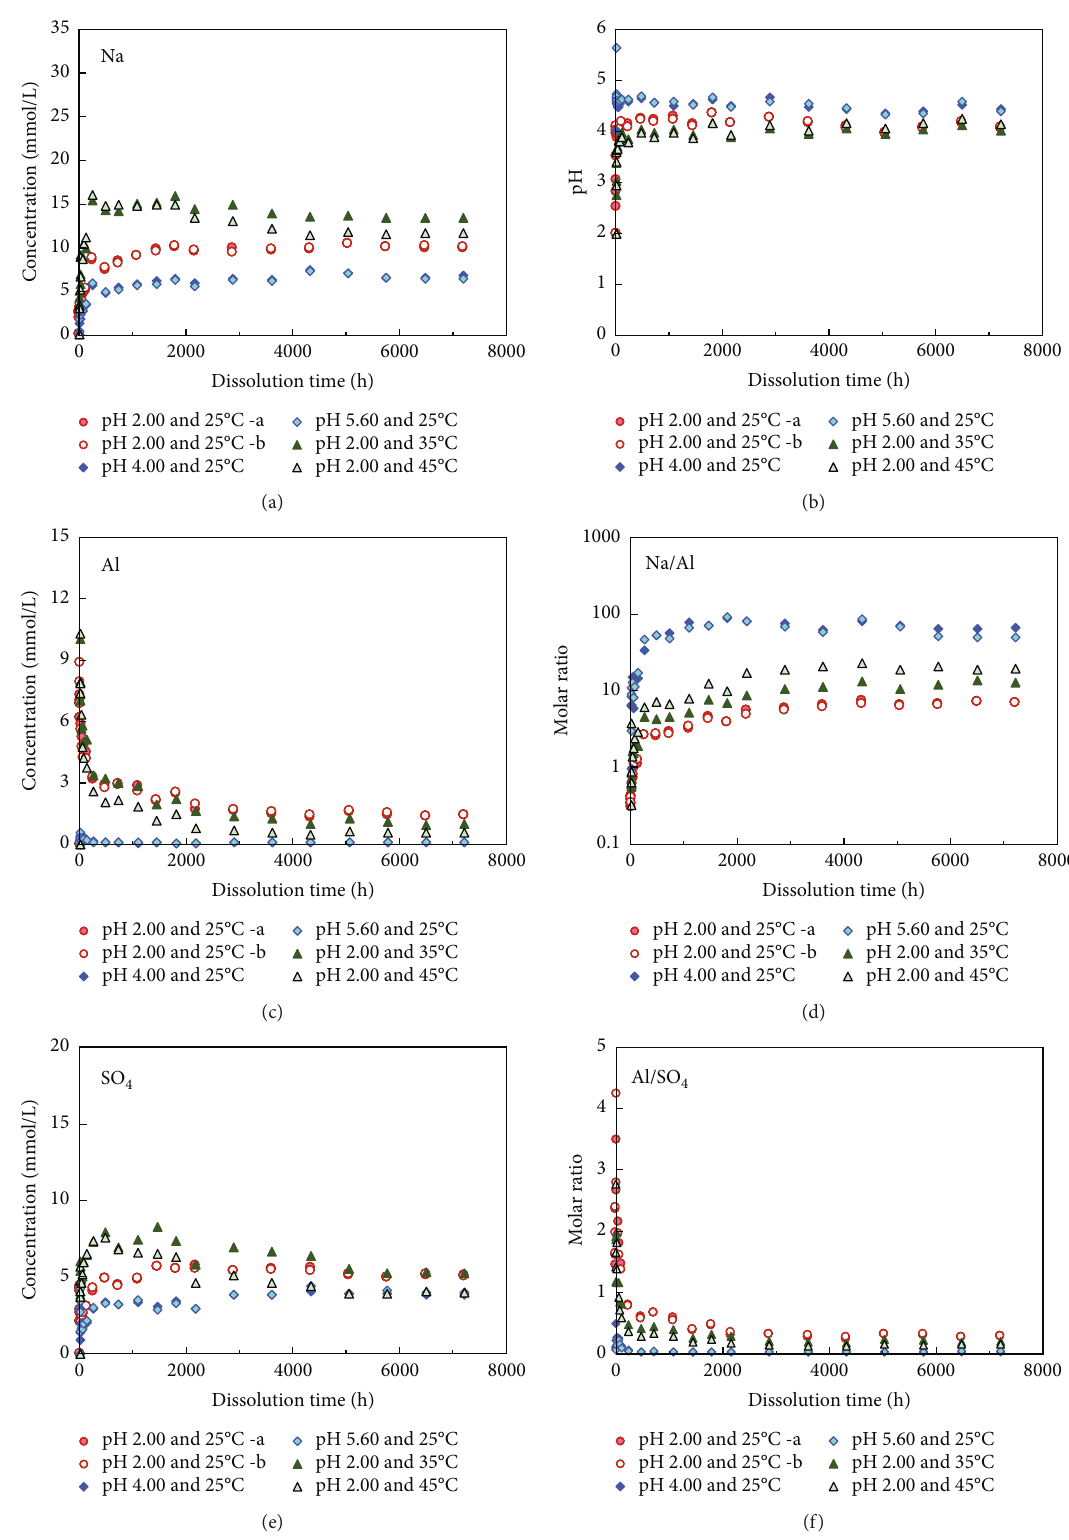
Figure 4: Aqueous evolution during the dissolution of the synthetic natroalunite at 25–45 ° C for